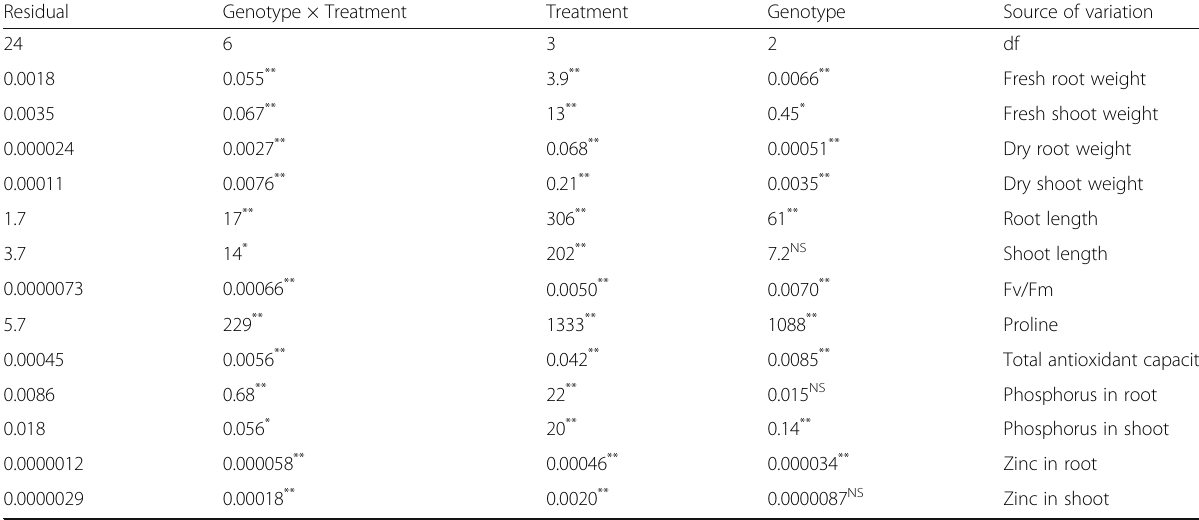
Table 1 Mean squares of absolute values for various seedling traits of the three rice genotypes grown in control, control + P. indica , drought and drought + P. indica